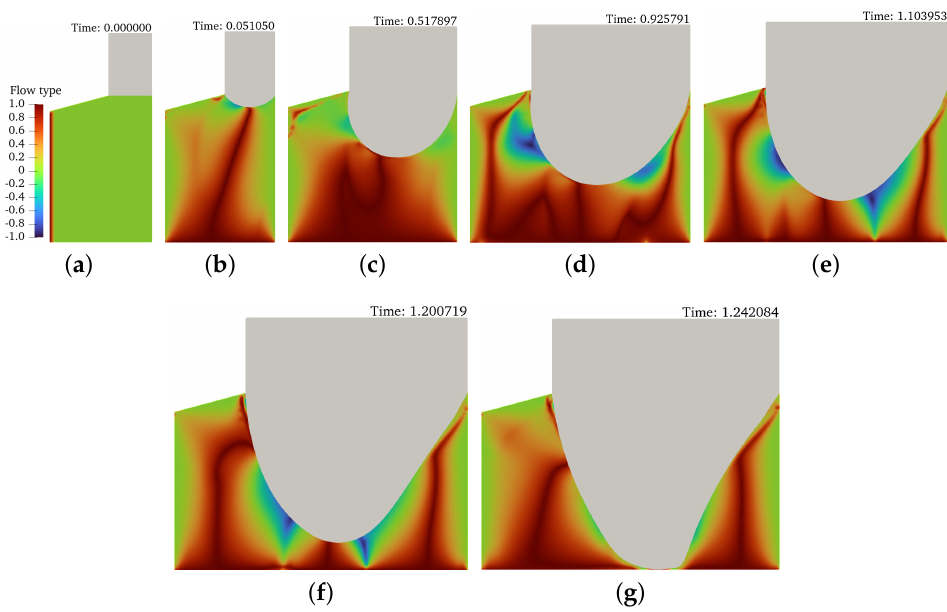
Figure 8. ( a – g ) The contour plots of flow type at different time steps for the simulation of Hexa-1 ink and the gravure velocity U = 2 mm/s.